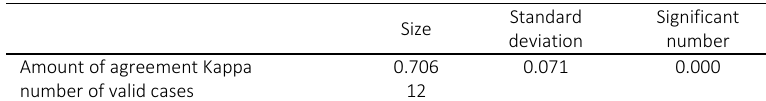
Table 4: Number of the agreement size